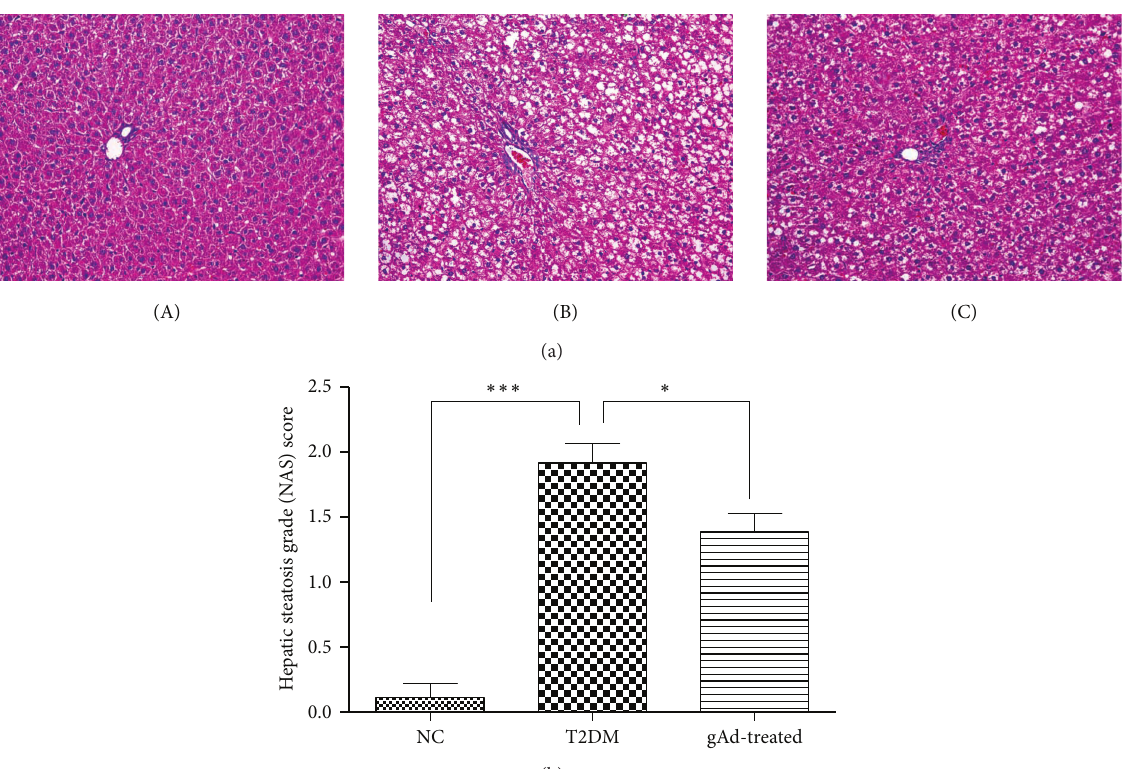
Figure 1: HE staining of liver specimens. (a) HE staining of liver specimens for NC group (A), T2DM group (B), and gAd-treated group (C) ( × 200). (b) NAFLD activity scores of liver specimens of three groups. ∗ 𝑃 < 0.05 , ∗∗∗ 𝑃 < 0.001 as compared to T2DM group.